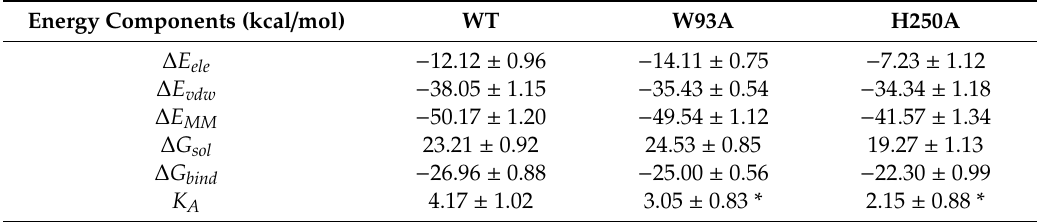
The binding free energy (kcal / mol) of WT, W93A, and H250A with ZINC05683641 complex and the values of the binding constants (KA) (1 × 10 5 L mol − 1 ) based on the fluorescence spectroscopy quenching. Energy Components (kcal / mol) WT W93A H250A ∆ E − 12.12 ± ele